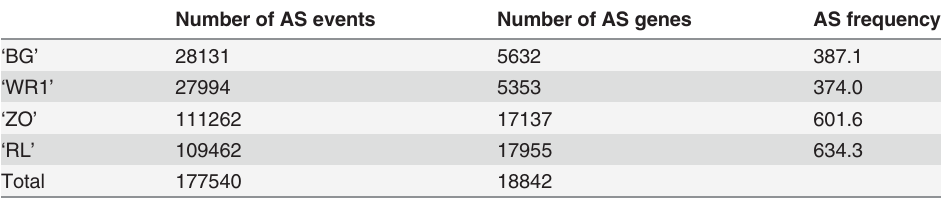
Table 3. Statistics of AS discovered from RNA-Seq